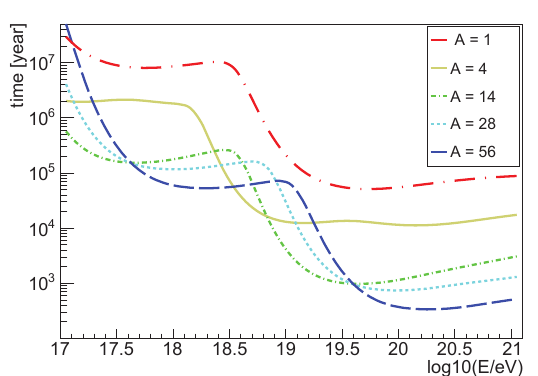
Figure 2. Timescales for photo-interactions in our prototype SBG for five di ff erent injected CR nuclear species as indicated in the legenda (see [23] for details).